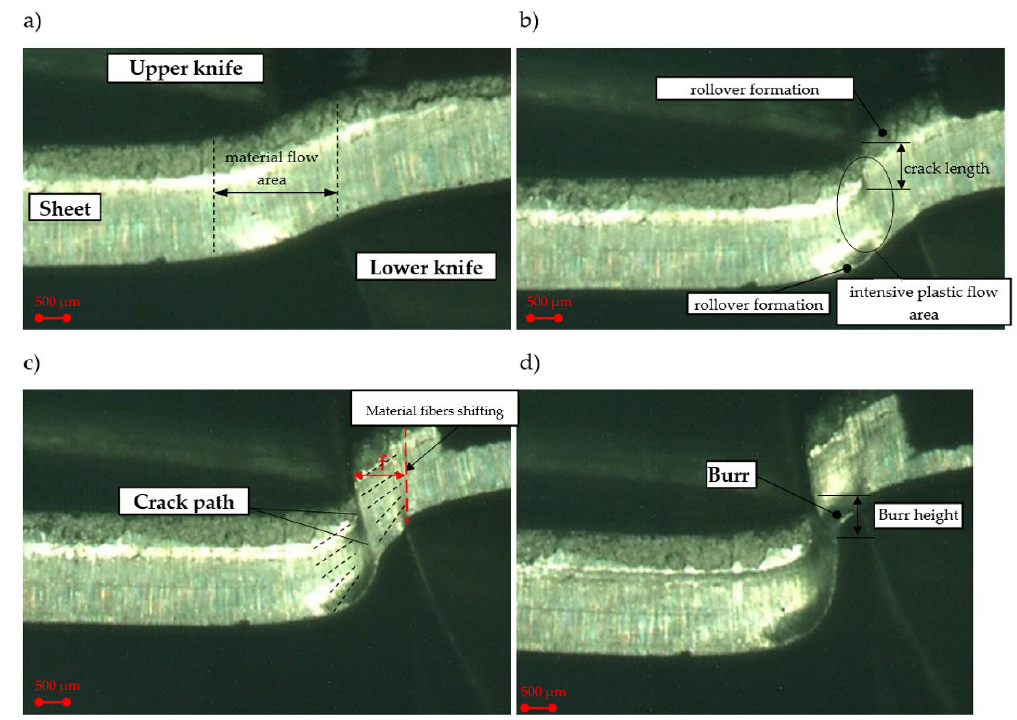
Figure 3. Shear-slitting process registered at the sheet cross section (h c = 0.15 mm, α = 7 ◦ ): ( a ) material plastic flow phase, ( b ) plastic flow with the beginning of the cracking phase, ( c ) burr formation in cracking phase, ( d ) final separation. Materials 2020 , 13 , x FOR PEER REVIEW